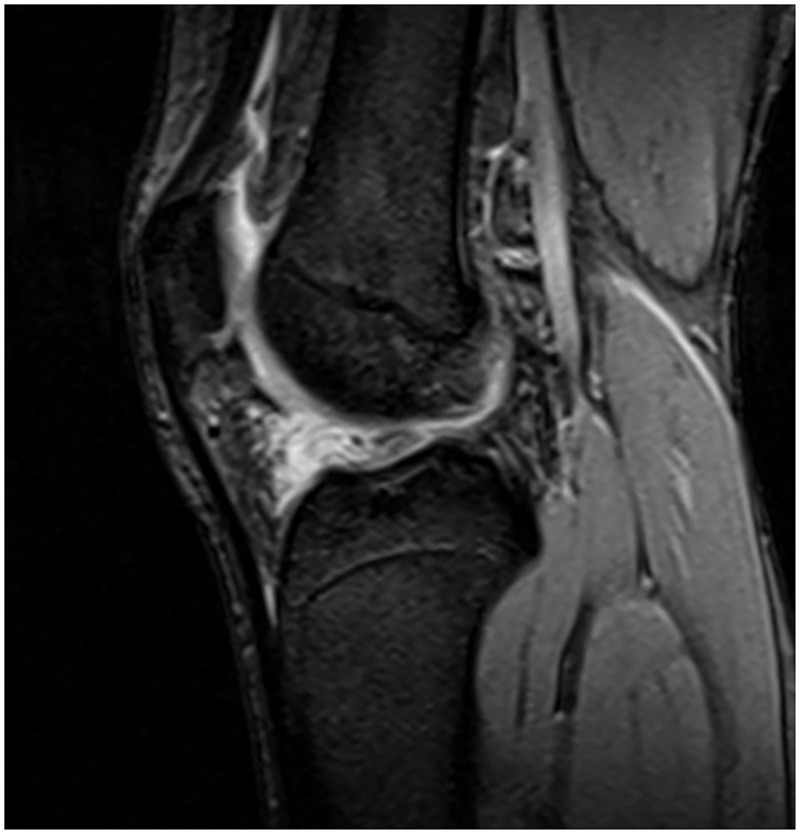
Sagittal proton density-weighted MRI of the knee of a 21-year-old male show that the disorder and irregular strip-like signal was observed in the AHLM and articular capsule.